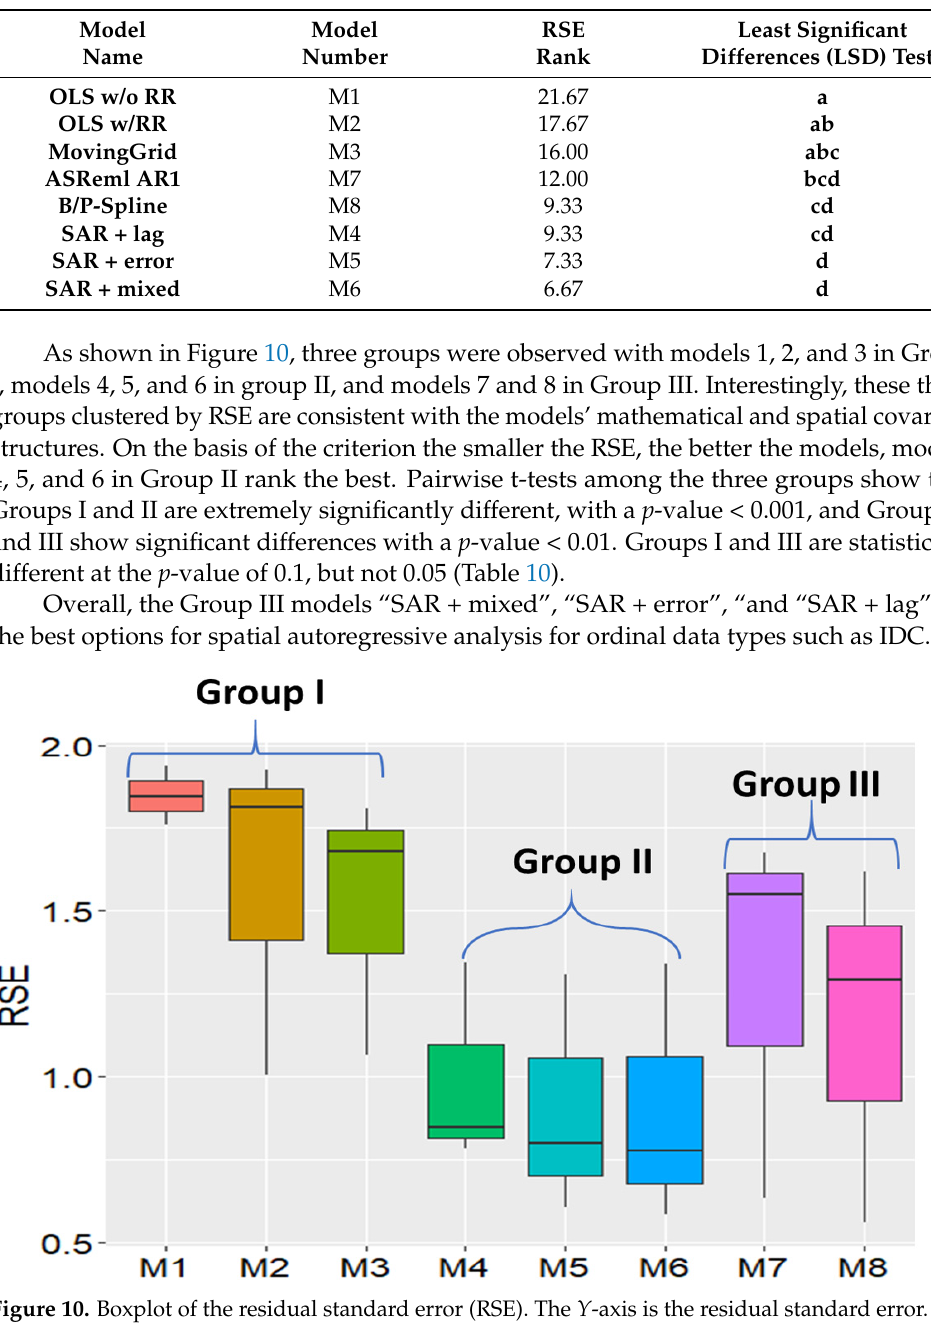
Table 9. Results of the Kruskal-Wallis and multiple comparison tests. Letters a to d indicate their difference reaches the least significant distance (LSD) with Fisher’s threshold (significance threshold of p -value < 0.05). Models sharing a letter are not significantly different. For example, Models 1 and 2, with shared letter “a,” have no significant difference. See model descriptions (OLS, SAR etc.) in